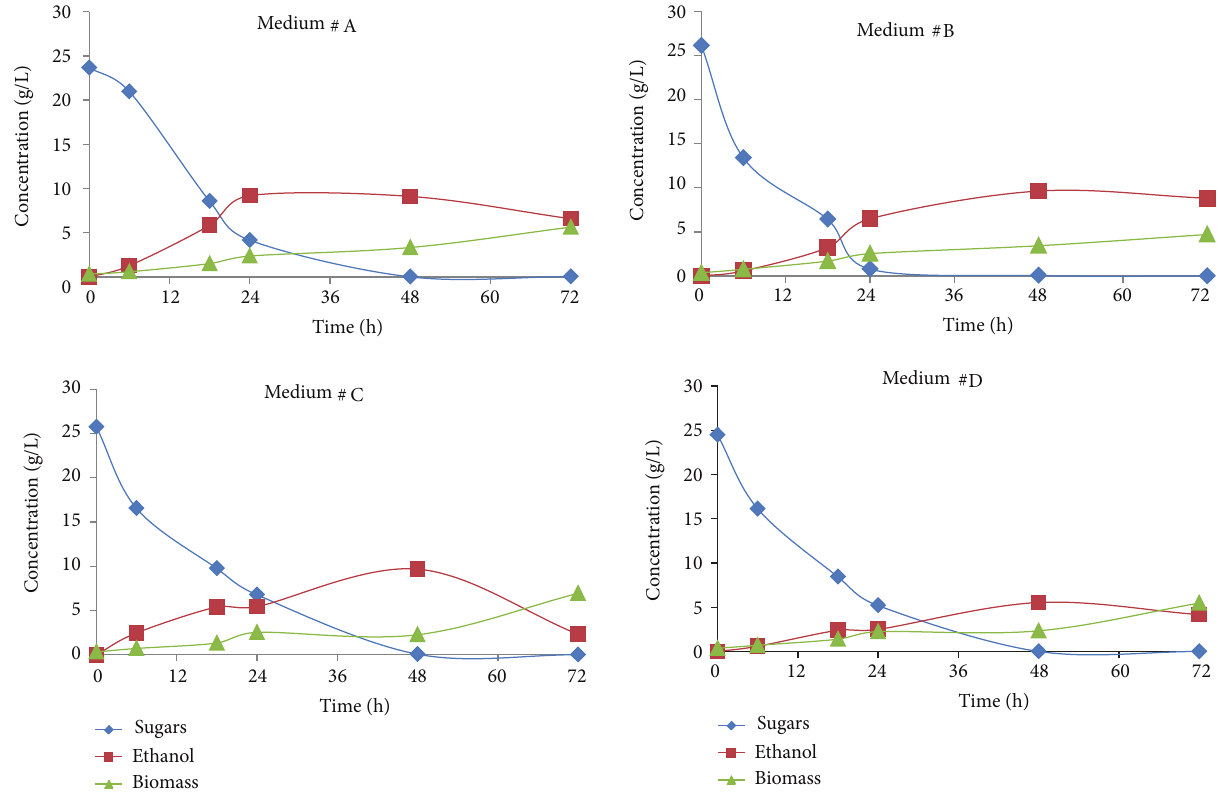
Figure 3: Fermentation of SBHH (sugarcane bagasse hemicellulosic hydrolysate) supplemented with different nutritional components using yeast Scheffersomyces shehatae UFMG-HM 52.2. Medium #A: 5g/L ammonium sulfate, 3g/L yeast extract, 3 g/L of malt extract [13]; medium #B: 5 g/L peptone, 3 g/L yeast extract, 3 g/L malt extract [13]; medium #C: 1.73g/L ammonium sulfate, 3.56 g/L potassium phosphate monobasic, 2.62 g/L yeast extract [14]; medium #D: 3 g/L yeast extract, 0.25 g/L of urea, 0.25 g/L calcium chloride, 0.25 g/L magnesium sulfate, 2.5 g/L potassium phosphate monobasic [15]. In all media, the nutrients were added to detoxified hemicellulosic sugarcane bagasse hydrolysate, used as sole carbon source.